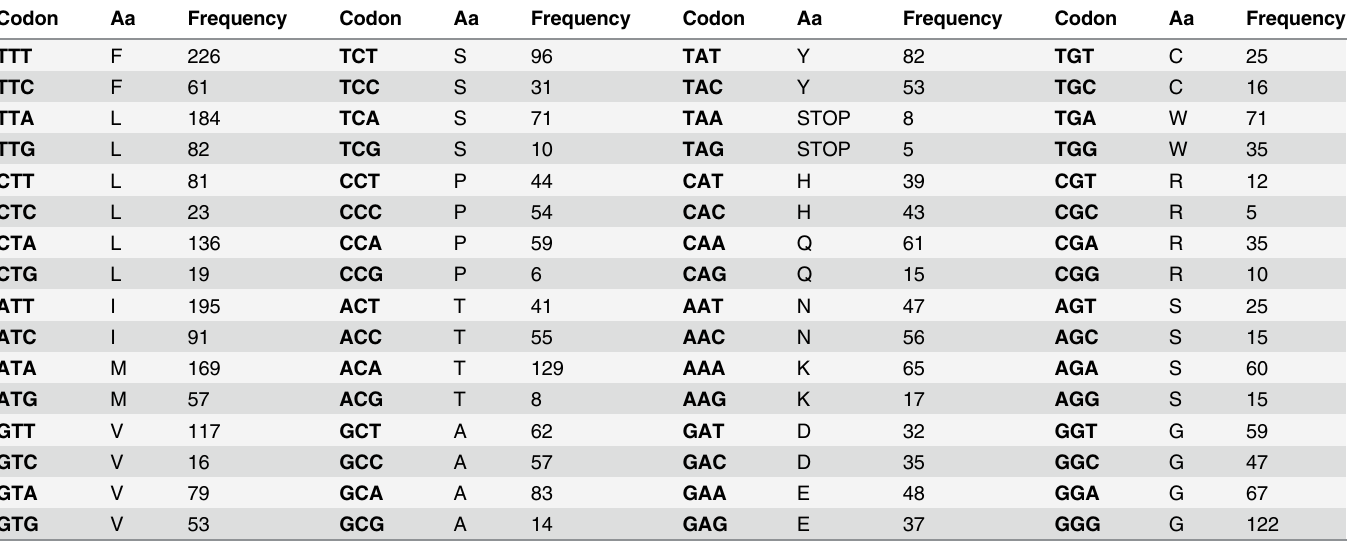
Table 2. Total codon usage across the protein-coding genes of the Strigamia mitochondrial